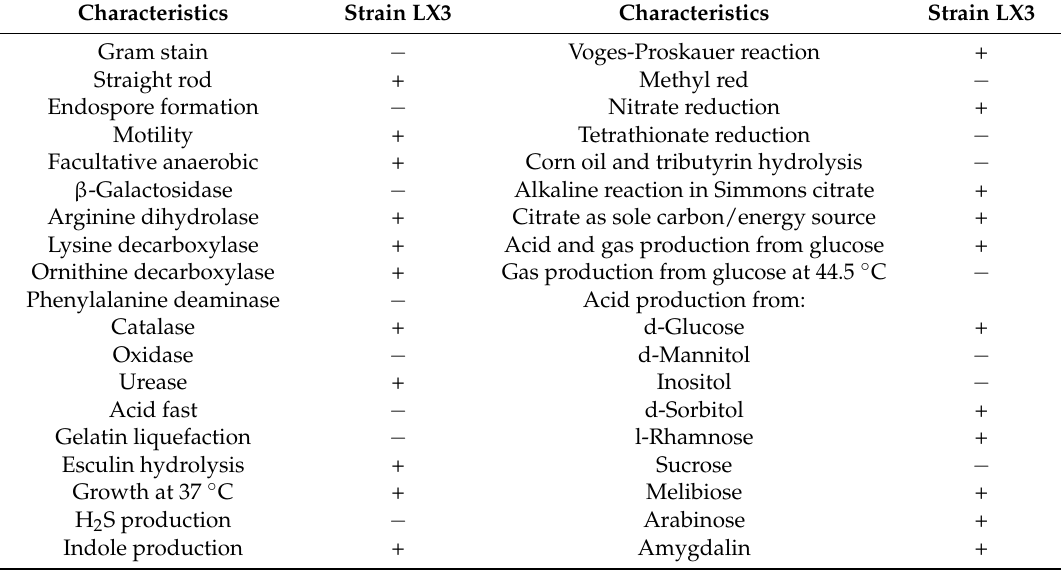
Table 1. Phenotypic characteristics of the newly isolated Enterobacter sp. LX3. Symbols: +, 90% or more strains were positive; − , 10% or less strains were positive.